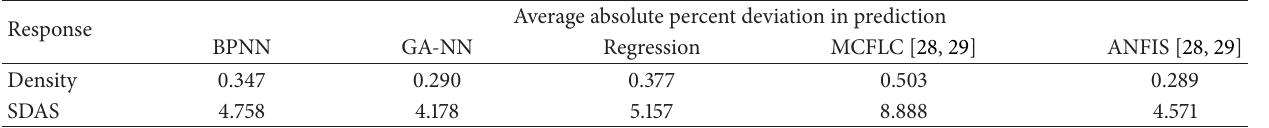
Table 4: Average absolute percent deviation in prediction of the responses (forward